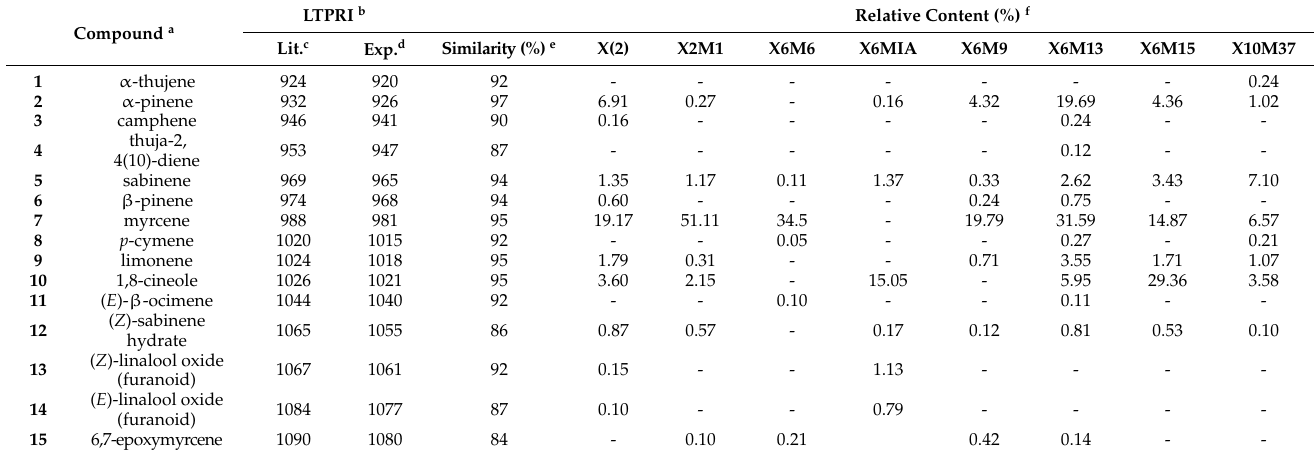
Table 2. Chemical composition of essential oils from eight new L. alba genotypes analyzed by GC × GC-MS. LTPRI Compound a